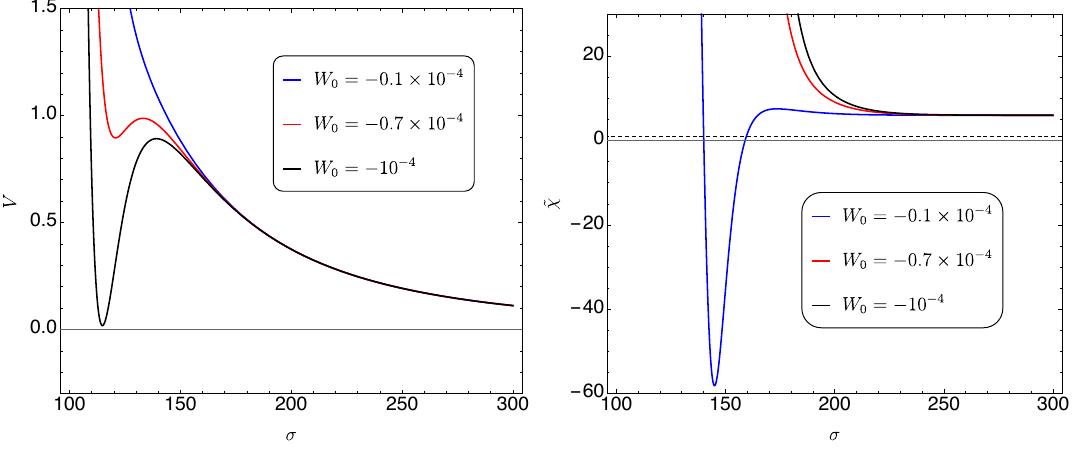
Figure 5 . KKLT potential for the parameters in the original ref. [78] in black. In red and blue we show alternative choices for W 0 . For the choice in blue the bound is violated, but the potential does not have a